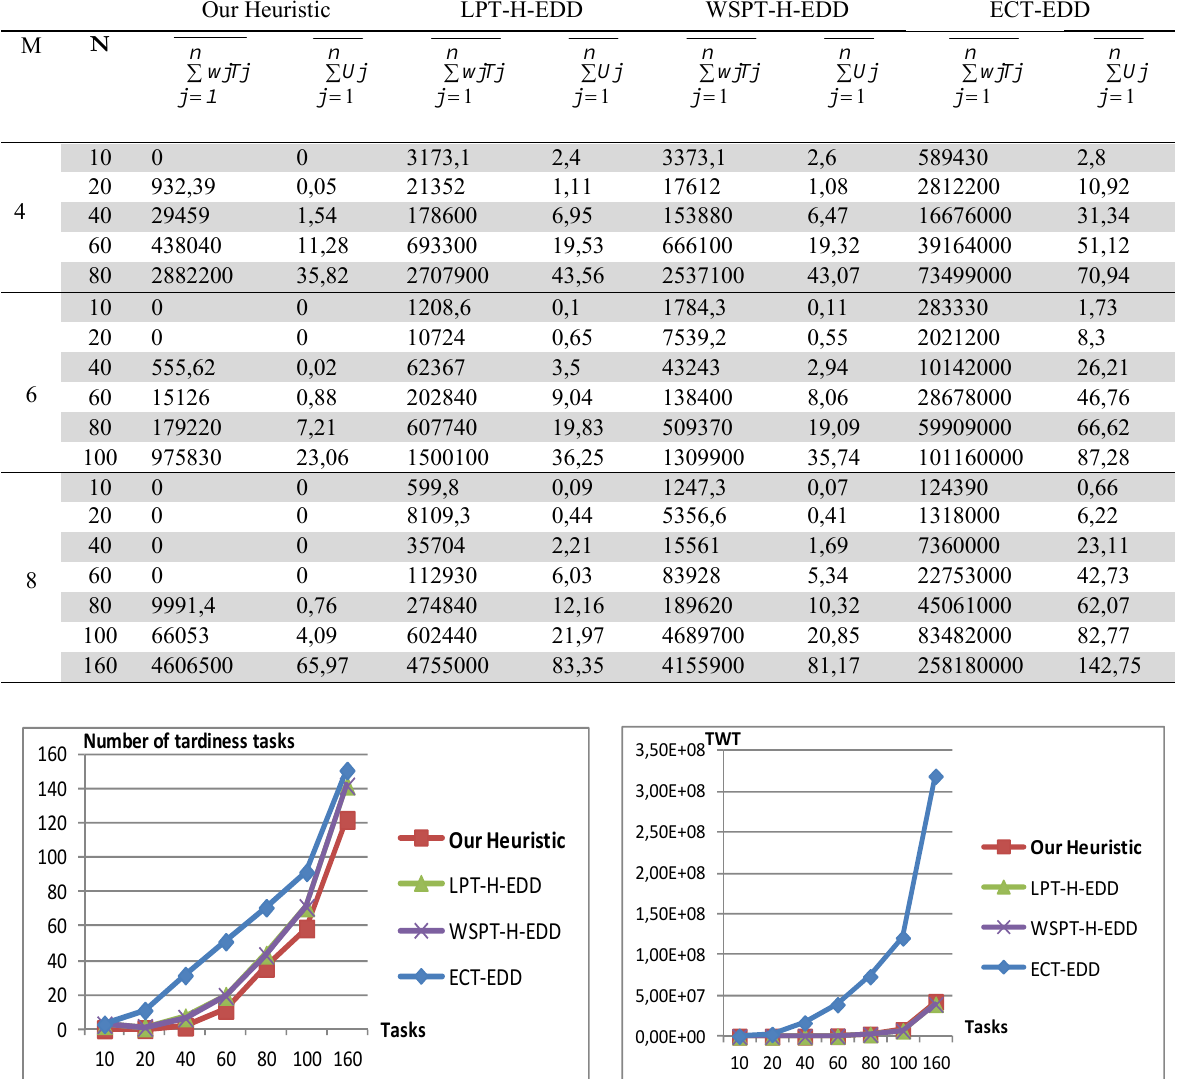
Results of all comparison experiments